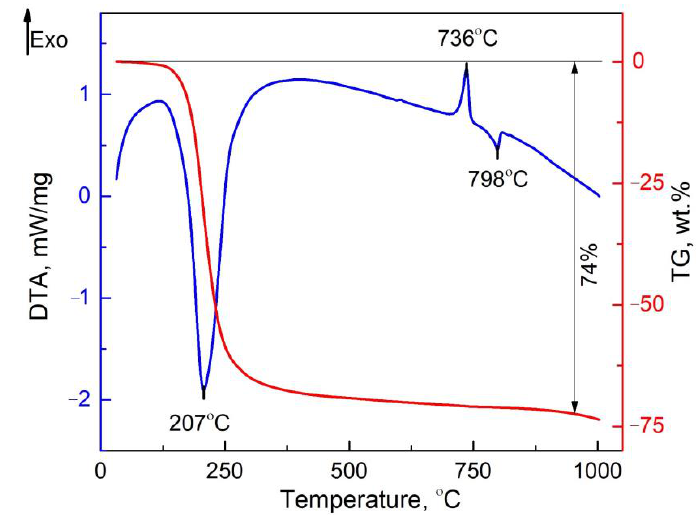
Figure 7. TG-DTA plots of ACH precipitated from the mother liquor.